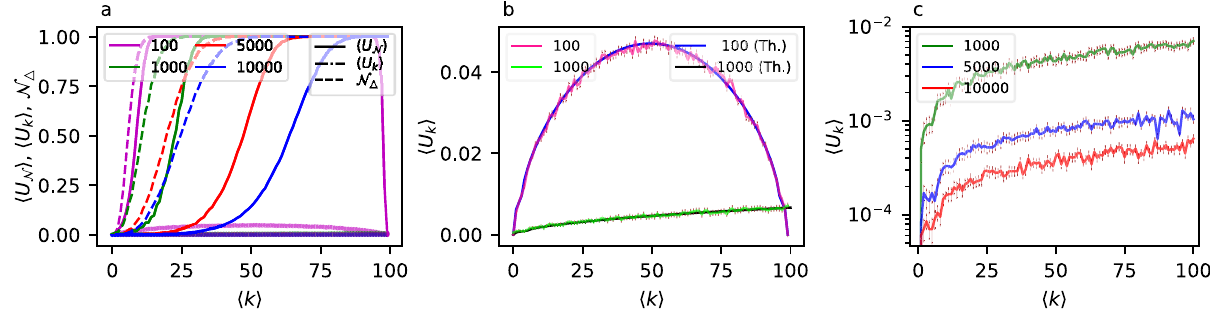
Figure 1. Neighborhood uniqueness, degree uniqueness and non-empty neighborhoods in ER networks with varying size and average degree. ( a ) The expected uniqueness of neighborhoods (cid:31) U N (cid:30) (continuous lines), degree uniqueness (cid:31) U k (cid:30) (semi-continuous lines, on the bottom of the panel) and number of neighborhoods N (cid:31) with at least one triangle (or, non-empty neighborhoods, in dashed lines) in ER networks of size 100, 1000, 5000 and 10,000 (computed as the mean of 10 independent network realizations), for values of average degree from 0 to 100. The degree uniqueness values are very close to 0 and for network sizes from 1000 to 10,000 they are below 0.02 and covered by each other. See panels ( b,c ) for a zoom of those curves. ( b ) Expected degree uniqueness for networks of size 100 and 1000 both from simulations, and the theoretical line, computed with Eq. (5). The means and errors (computed as standard error of the mean) are computed over 400 independently simulated networks for the networks with 100 nodes, and 20 independently simulated networks for the ones with 1000 nodes. This is because those are bigger systems, thus self-averaging, i.e., the variance between samples of the larger networks are smaller. ( c ) Expected degree uniqueness (cid:31) U k (cid:30) (in a log scale) for networks of size 1000, 5000 and 10,000, for a range of average degree (cid:31) k (cid:30) from 0 to 100. The error bar represents the standard error of the mean. The means and errors are computed over 20 independently simulated networks. In this panel, the vertical axis representing the expected degree uniqueness is in log real-world networks 47 ) and makes nodes heterogeneous in terms of degree. In the BA model, a network is generated by adding one node at a time and connecting it with already existing nodes, with a preferential attachment model (i.e. a link to an existing node is created with a probability proportional to the number of edges that are already connected to that node). In contrast to ER and BA, the WS and the RGG can be used to generate networks with realistic neighborhood densities (i.e., clustering coefficient values). The WS model has a parameter β representing the probability of rewiring each edge from a regular lattice structure (if β = 1 , the generated graph is a random graph similar to a ER graph). The RGG (in its soft version, which we use) is constructed by randomly placing n nodes in an Euclid- ean space uniformly. If two nodes are within a given radius r , they are connected with a specified probability (in our case, an exponential distribution). The expected average degree of RGG is roughly � k � ≈ π( n − 1 ) r 2 . The WS and RGG models are not as easily amenable to derivations of explicit equations for uniqueness as the ER model, and instead, in “Uniqueness maps”, we show the uniqueness values for suitable parts of the parameter space of all of the models.